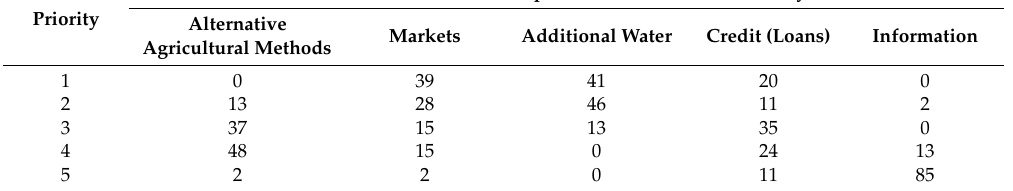
Table 4. Ranking of project potentials by the farmers. Potential 1 is more important than 2, which is more important than 3, and so on.